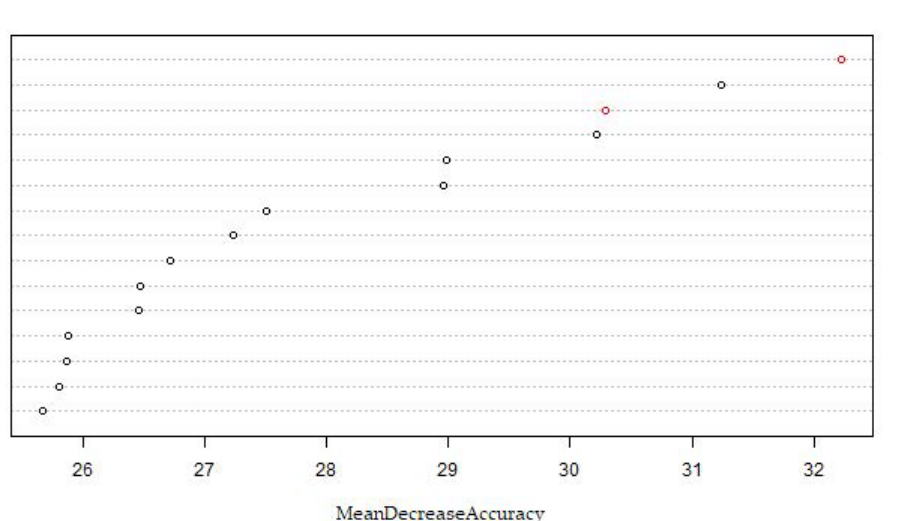
Figure 2. Importance plot of the remaining variables of Test case 3. The two Sentinel-1 parame- ters 20180618_20180630_VH and 20180618_20180630_CPR (in red letters) remain in the classifica- tion